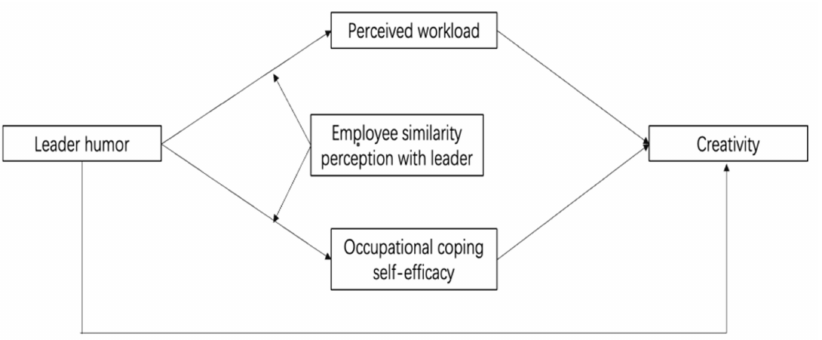
Figure 1. Hypothetical